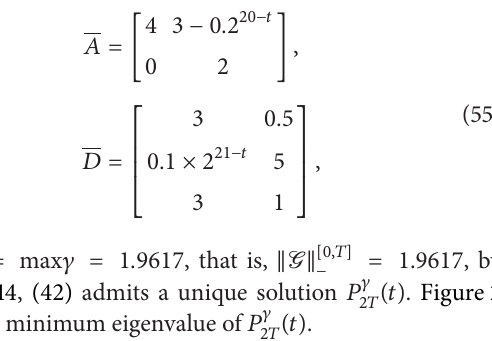
For 𝛾 1 = max 𝛾 = 1 . 5262, that is, ‖ G ‖ [ 0 ,𝑇]